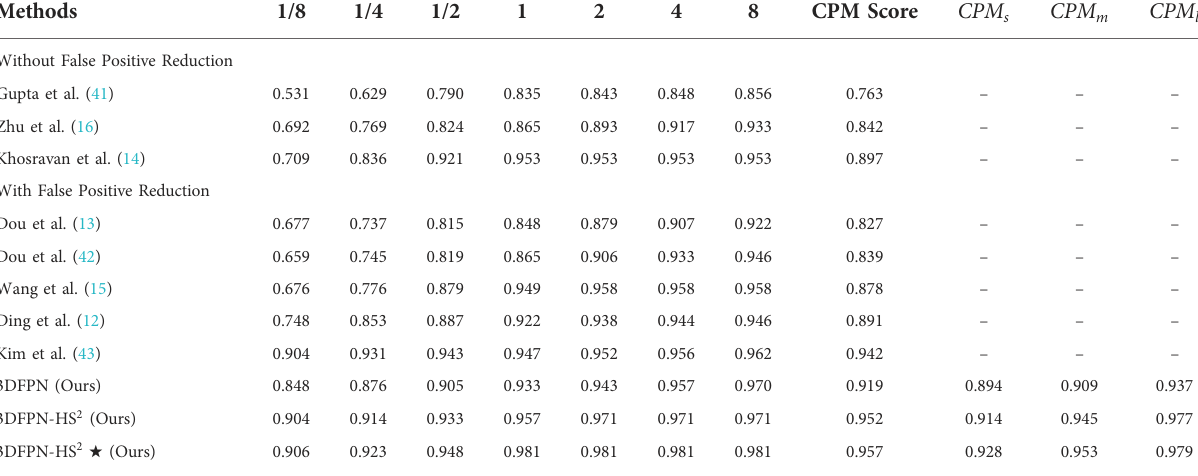
TABLE 4 FROC Performance comparison with the state-of-the-art methods on LUNA16 dataset: sensitivity and the corresponding false positives at 1 = 8 , 1 = 4 , 1 = 2 , 1 , 2 , 4 , 8 per scan. Our 3DFPN-HS 2 method achieves the best performance (with . 90 % sensitivity) at most of false positive levels and signi fi cantly outperforms others especially at the low false positive levels ( 1 = 8 and 1 = 4 ). 3DFPN indicates the nodule detector without false positive reduction. 3DFPN-HS 2 is with false positive reduction. 3DFPN-HS 2 w shows the results applying pre-trained model trained on the NLST dataset. CPM s , CPM m , and CPM l show the average detection performance for the small, medium, and larger nodules,